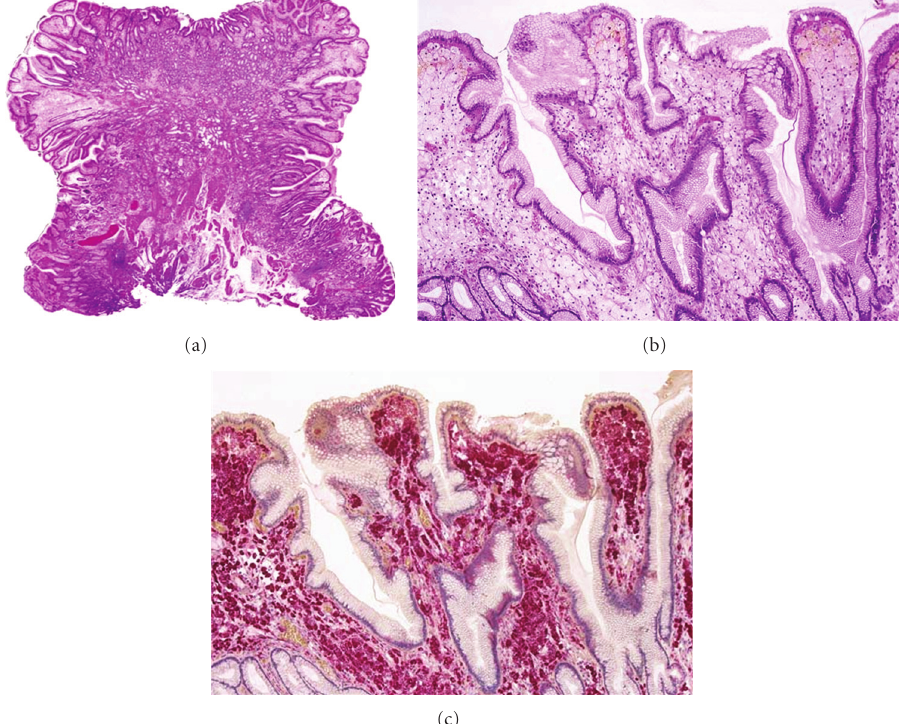
Figure 2: (a) The resected specimen obtained by endscopic mucosal resection showed lengthened gastric foveolae in the superficial portion in the polyp (HE stain, × 4). (b) Collections of large foamy histiocytes were seen in the lamina propria (HE stain, × 25). (c) The histiocytes represented a positive immunochemical reaction for CD68 ( ×